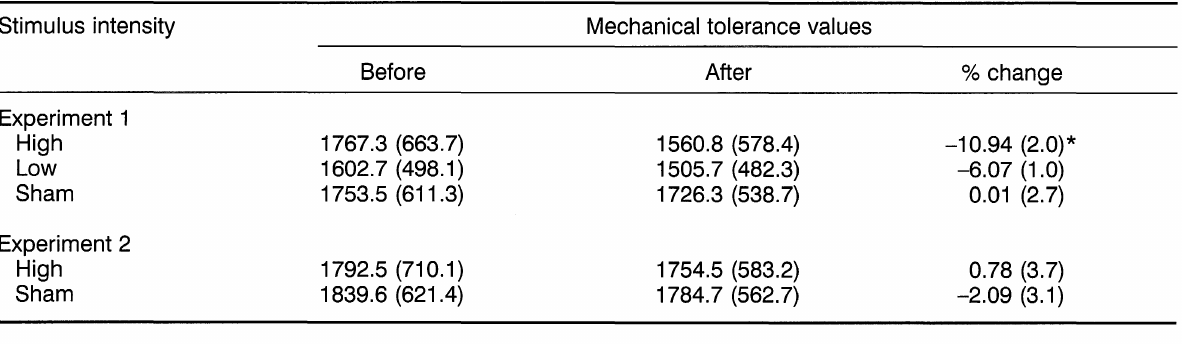
TABLE II. Mean (SD) mechanical tolerance values (gms) before and after TSE and mean (SE) percentage change. There was a significant reduction in pain tolerance following high intensity TSE in comparison to sham. (* = p <